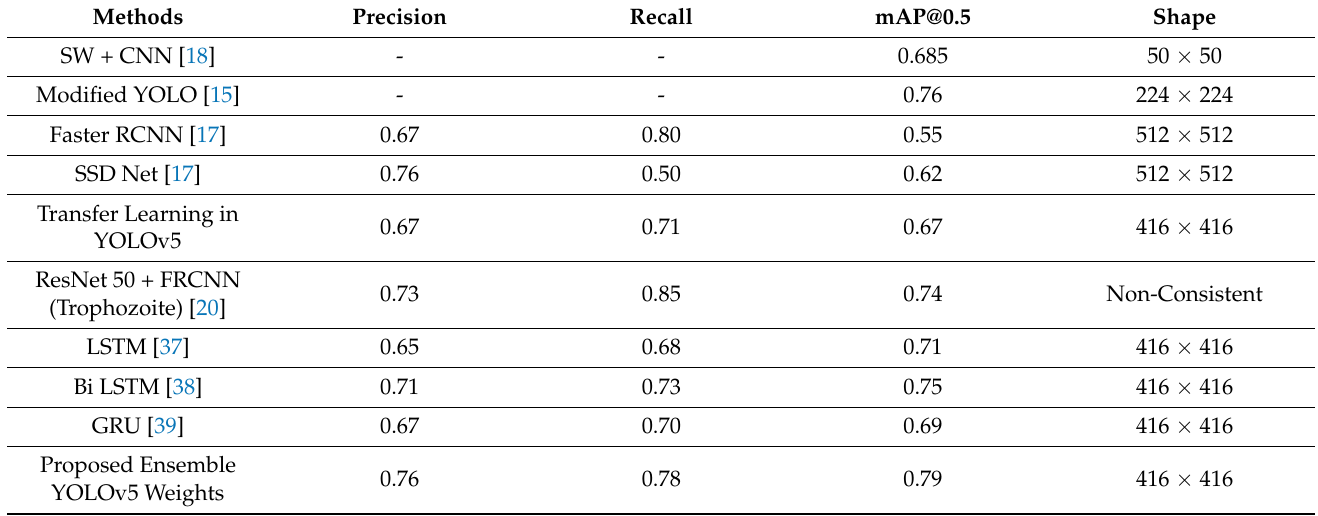
Table 5. Comparison of different methods based on precision, recall, and mAP values with the proposed